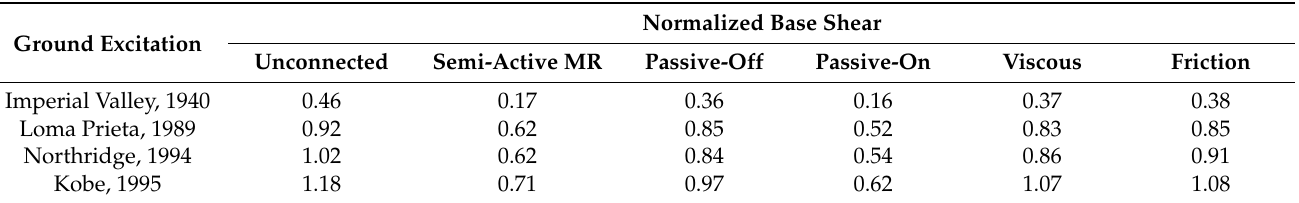
Table 6. Comparison of peak normalized base shear of the coupled stiff building under different control strategies when dampers are arranged in Configuration 1.